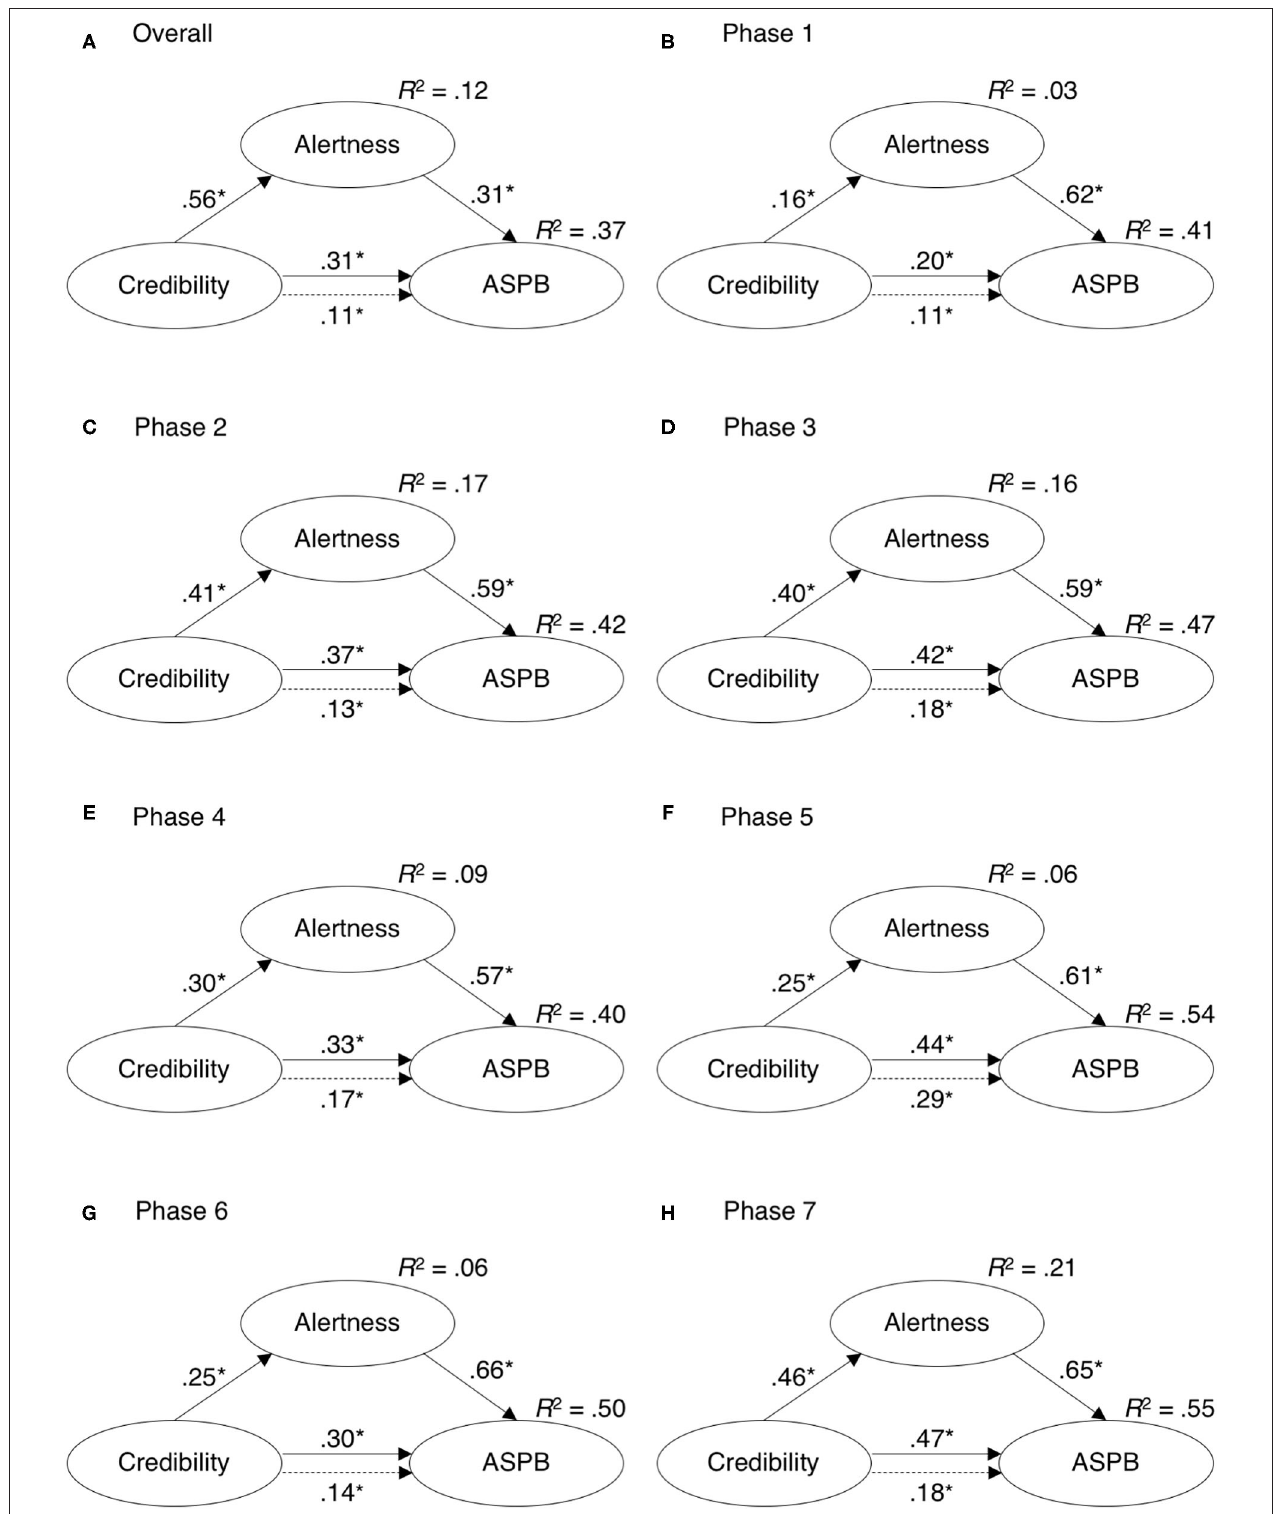
FIGURE 6 | Mediation analysis results for predicting engagement in actual self-protective behavior (ASPB) from perceived credibility of information in (A) the entire duration of measurement and (B–H) in different psychological phases of the epidemic.